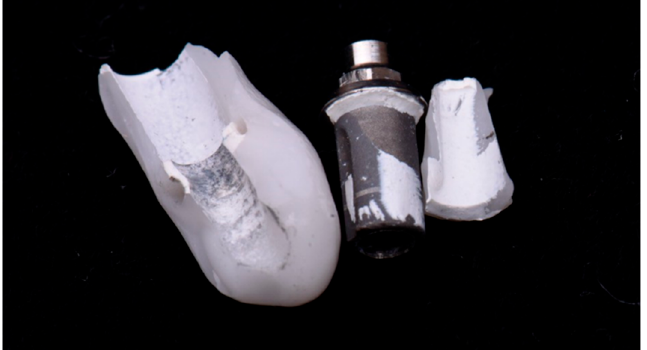
Figure 7. Fracture lines over the medial and distal walls. The cement layer of the fractured sample remains on the ceramic surface and the titanium base.